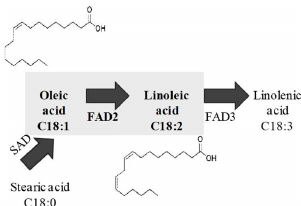
Figure 1. Schematic representation of the reaction catalyzed by fatty acid desaturase 2 (FAD2). FAD2 catalyzed the formation of a double bond at the Δ 12 position to produce linoleic acid. FAD3: fatty acid desaturase 3; SAD: stearic acid desaturase. Int. J. Mol. Sci. 2018 , 19 , x FOR PEER REVIEW